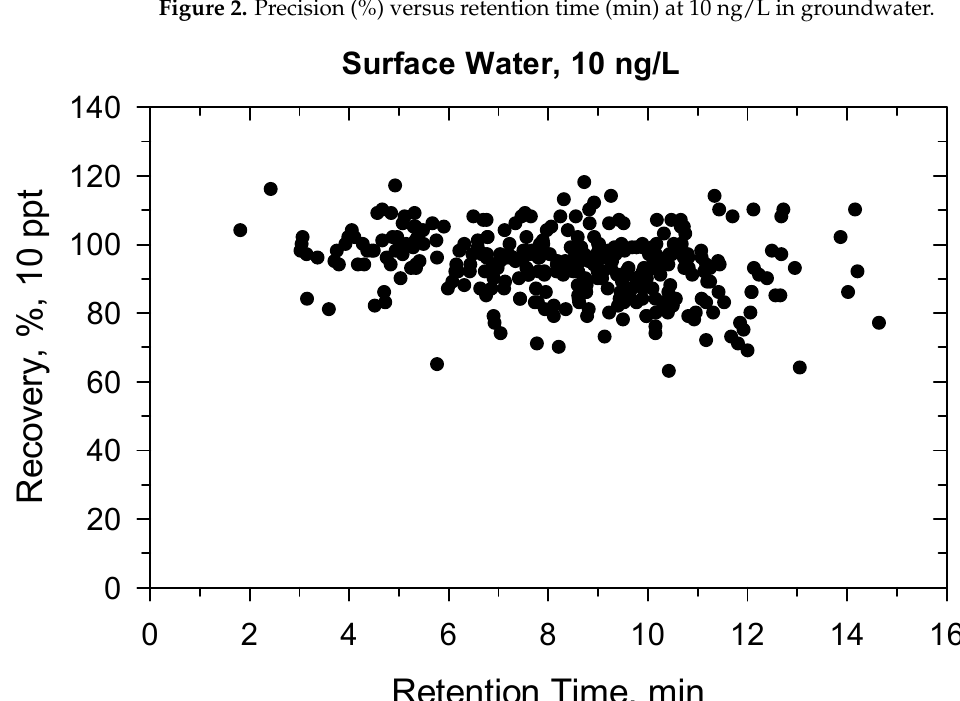
Molecules 2022 , 27 , x FOR PEER REVIEW 6 of 17 Figure 2. Precision (%) versus retention time (min) at 10 ng/L in groundwater. Figure 2. Precision (%) versus retention time (min) at 10 ng/L in groundwater.